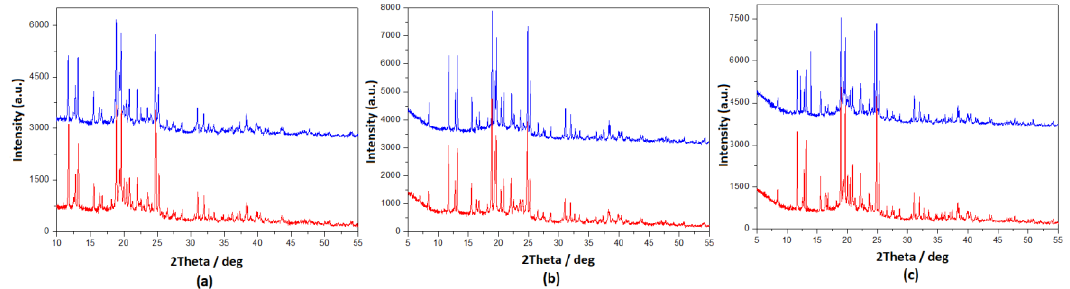
Figure 10. X-ray diffraction (XRD) diagrams of ( a ) milk chocolate, ( b ) dark chocolate and ( c ) white chocolate without DSP (blue lines) and of drug-loaded formulations (red lines).